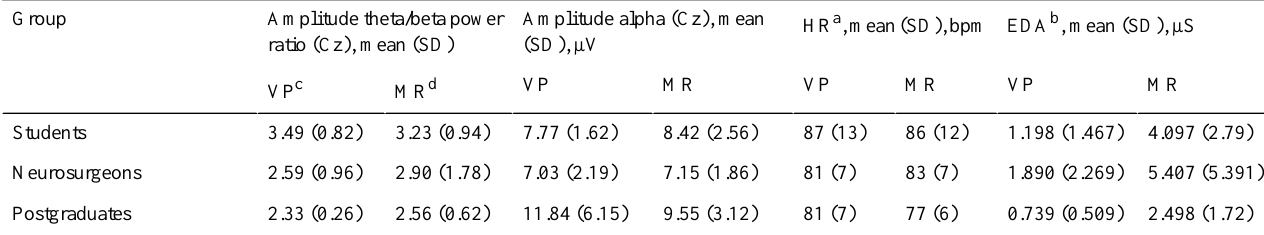
Table 4. Biosignal averages per group for the virtual reality/mixed reality educational episode.